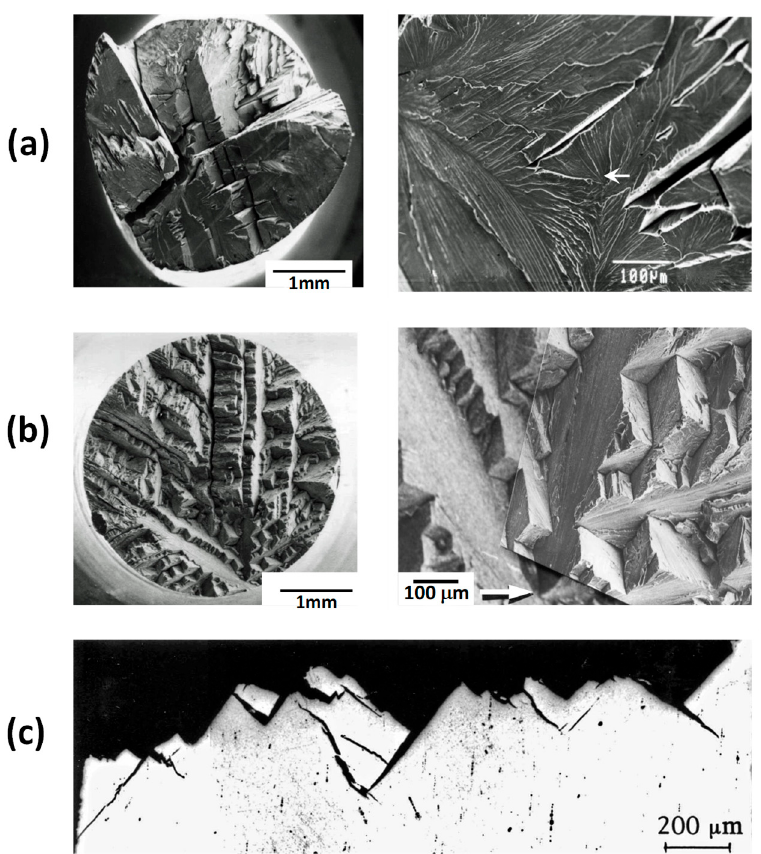
Figure 6. Macroscopic (left) and microscopic (right) SEM views of fracture surface of tensile specimen tested at ( a ) room temperature and ( b ) tensile specimen tested at − 196 °C. ( c ) Optical microscope image showing a lateral view of fracture surface of tensile specimen tested at − 196 °C. White arrows indicate the initiation fracture zone.